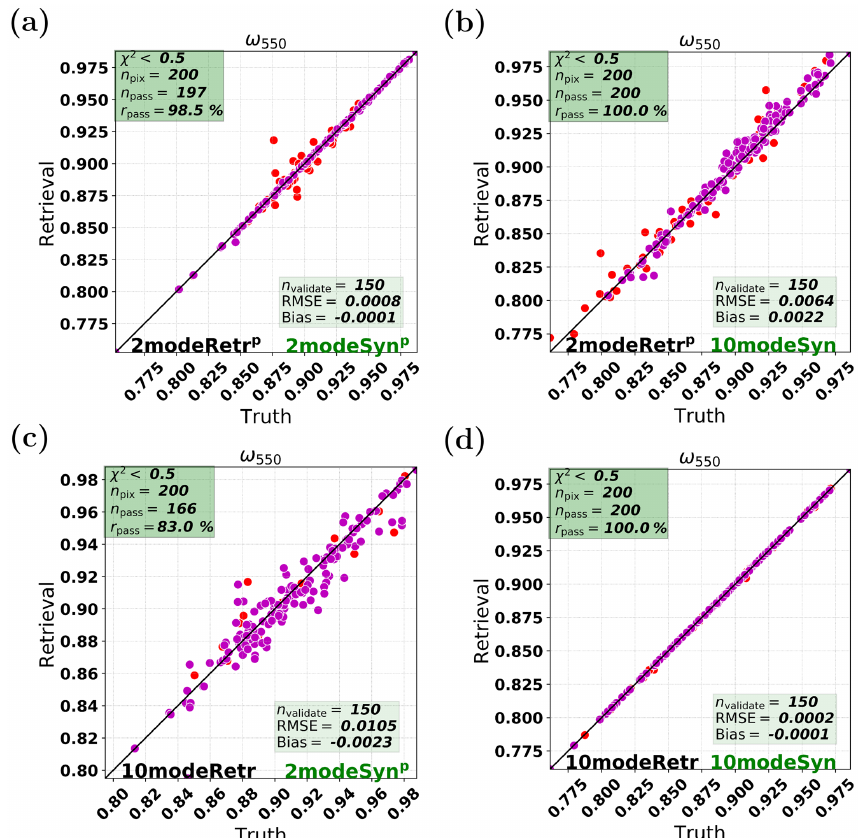
Figure 5. Synthetic retrievals: single scattering albedo (SSA) with the parametric two-mode retrieval (2modeRetr p ) and the 10-mode re- trieval (10modeRetr). The red and magenta points represent n pass and n validate points, respectively. The measurements are the parametric two-mode synthetic measurement (2modeSyn p ) and the 10-mode synthetic measurement (10modeSyn). (a) 2modeRetr p on 2modeSyn p . (b) 2modeRetr p on 10modeSyn. (c) 10modeRetr on 2modeSyn p . (d) 10modeRetr on 10modeSyn. Table 4. State vector for parametric two-mode retrieval and multimode